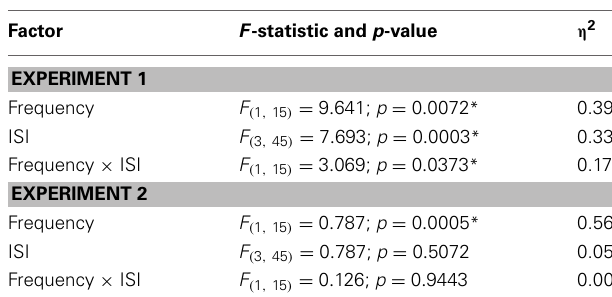
Table 4 | Statistics for the low and high frequency analysis to examine the impact of Weber’s Law by limiting the influence of response bias by using d (cid:2)